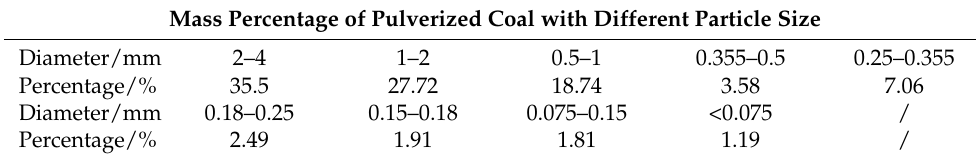
Table 1. Mass percentage of pulverized coal with different particle size. Mass Percentage of Pulverized Coal with Different Particle Size